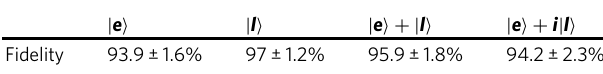
Table 1 Storage fi delity of time-bin qubits with μ =